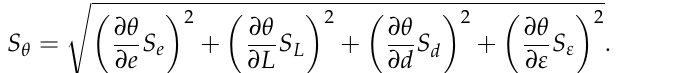
( b ) Figure 10 . Curve illustrating : ( a ) values of composite quantity θ , together with standard measuring uncertainty due to the measurement of e , L , d , ε . ( b ) standard measuring uncertainty values for com ‐ posite quantity θ due to the measurement of e , L , d , ε .